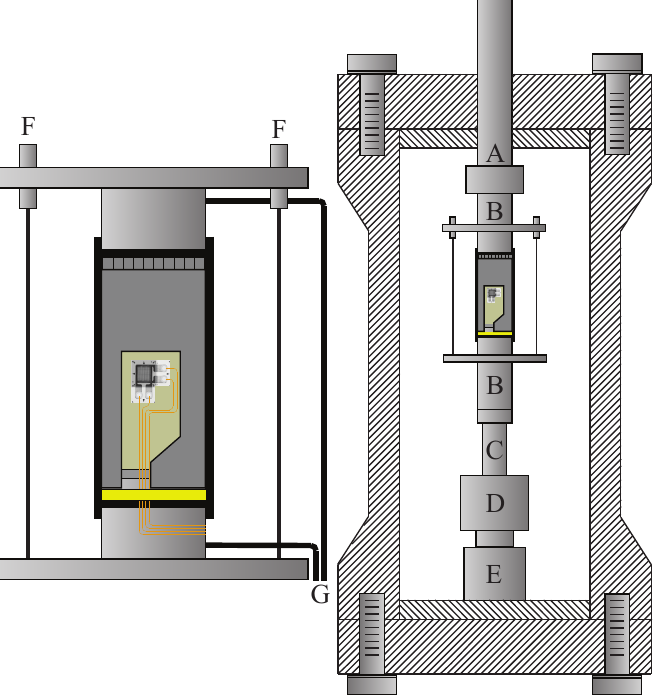
Figure 1. Apparatus schematics with letters indicating the different components: piston ( A ), top and bottom endcaps with embedded P- and S-wave transducers ( B ), piezoelectric force sensor ( C ), piezoelectric actuator ( D ), internal load cell ( E ), linear variable displacement transducers (LVDTs) ( F ), and pore fluid lines ( G ). Added to that, the specimen (regular and superimposed) with attached strain gauges (but without any letter indicators) mediates two sintered plates, as well as being covered by a mesh to ensure pore pressure equilibrium inside the enclosing rubber sleeve. Lozovyi and Bauer [63] further elaborate on the different